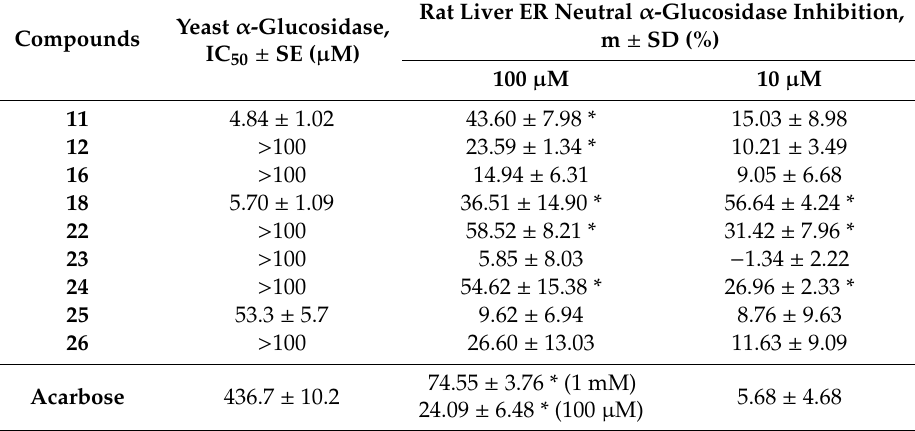
Table 6. Inhibition of α -glucosidases by the compounds 11 , 12 , 16 , 18 and 22–26.